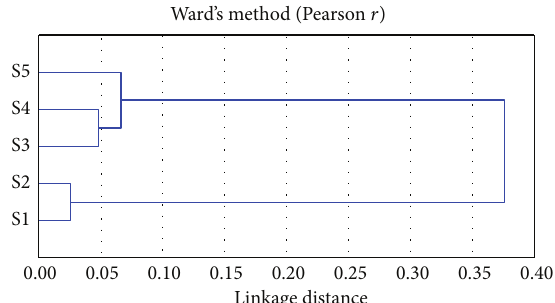
Figure 4: Dendrogram showing clustering of sampling sites in Mangla